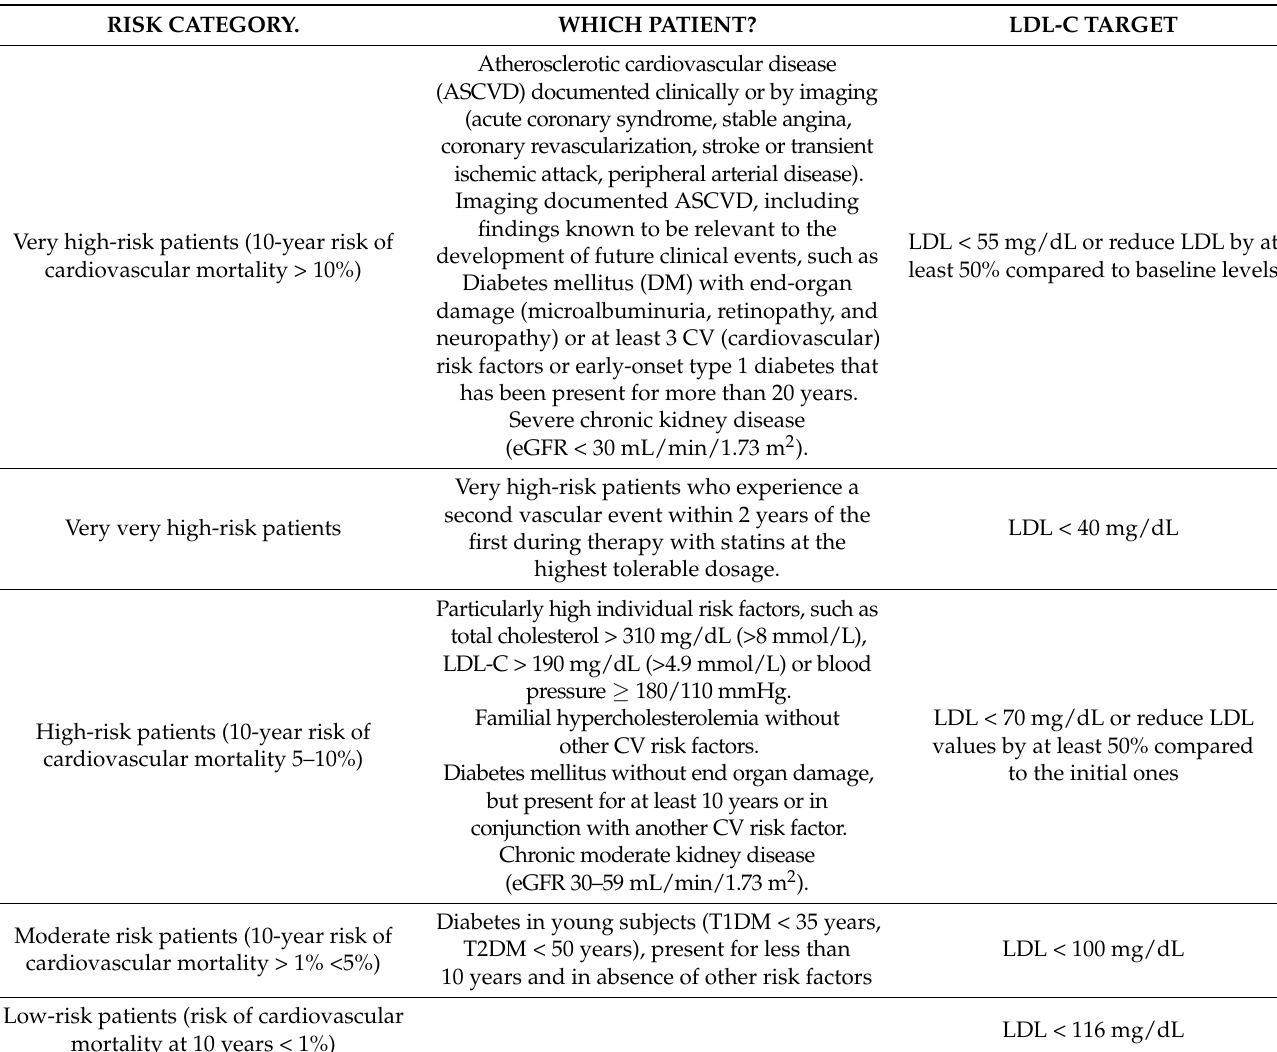
Table 1. LDL-C target according to cardiovascular